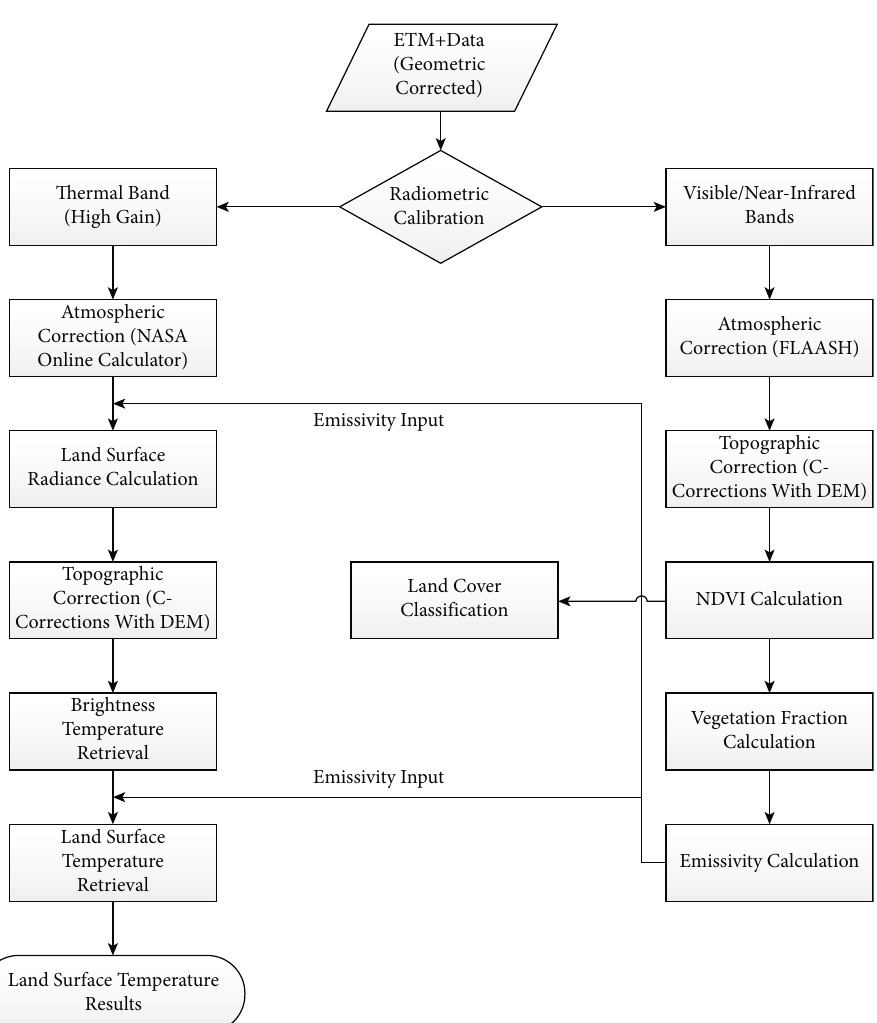
Figure 3: Landsat 8 data processing